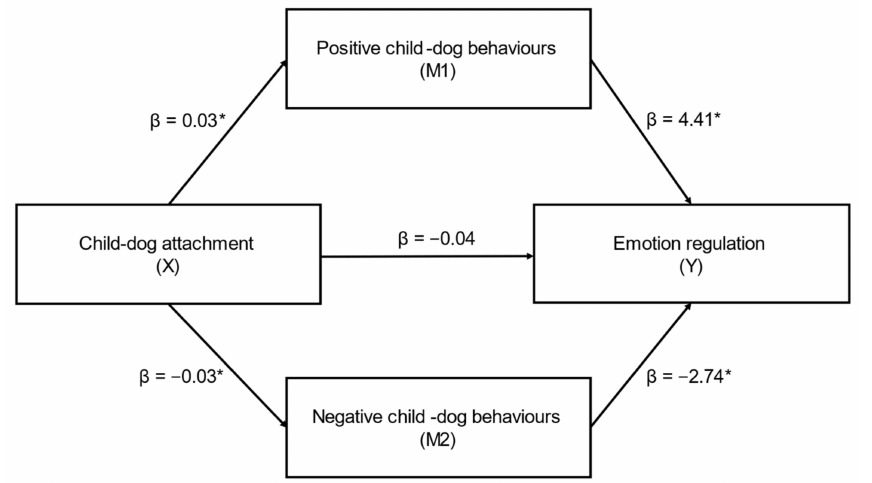
Figure 5. Positive and negative child–dog behaviours as mediators in the relationship between child–dog attachment and emotion regulation (ER) ( n = 83) (ab cs = 0.45, large effect). Note: * = significant pathway.